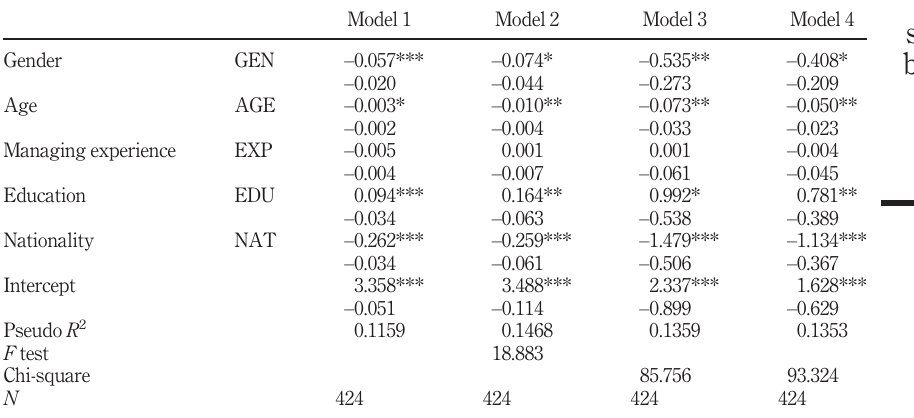
Table VII. Robustness testing